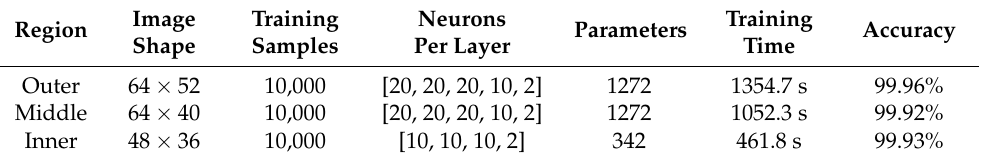
Figure 2. Samples of the data used for the training and testing of the local maxima finder network for the inner region of the LHCb calorimeter. The training input sample ( a ) is artificially generated and the output sample for training ( b ) is obtained applying the CA rules on the ( a ) sample. The testing input sample ( c ) is an LHCb simulation and the testing output sample ( d ) again generated applying the CA rules on sample ( c ) and represent the expected output from the network. Then image ( e ) is the real output obtained from the network trained to reproduce the CA when sample ( c ) is on the input, and is compared to sample ( d ) to obtain the accuracy value. Table 1. Parameter summary of the local maxima finder neural